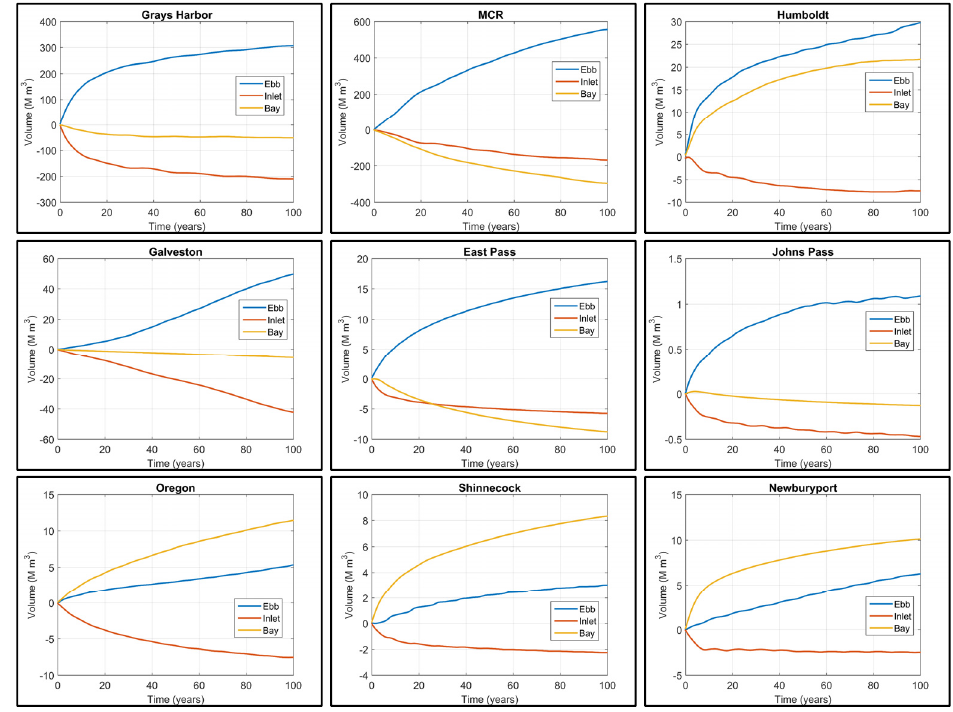
Figure 5. Change in sediment volume during the 100-year simulation. Units are millions of cubic meters.